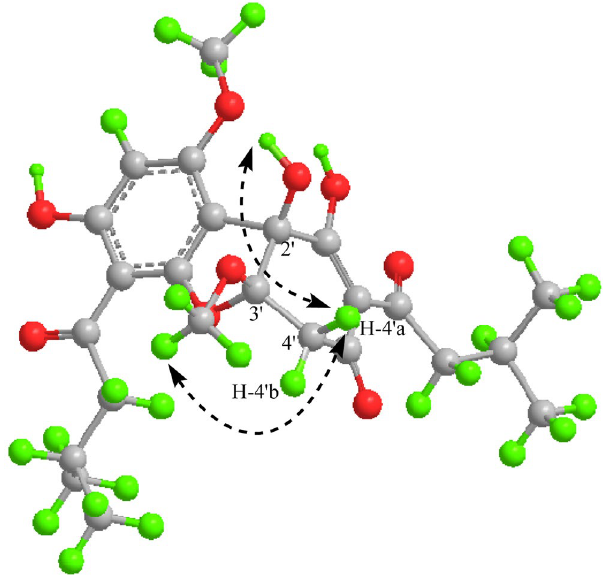
Figure 3. The key ROESY correlations (H → H) of 1 .